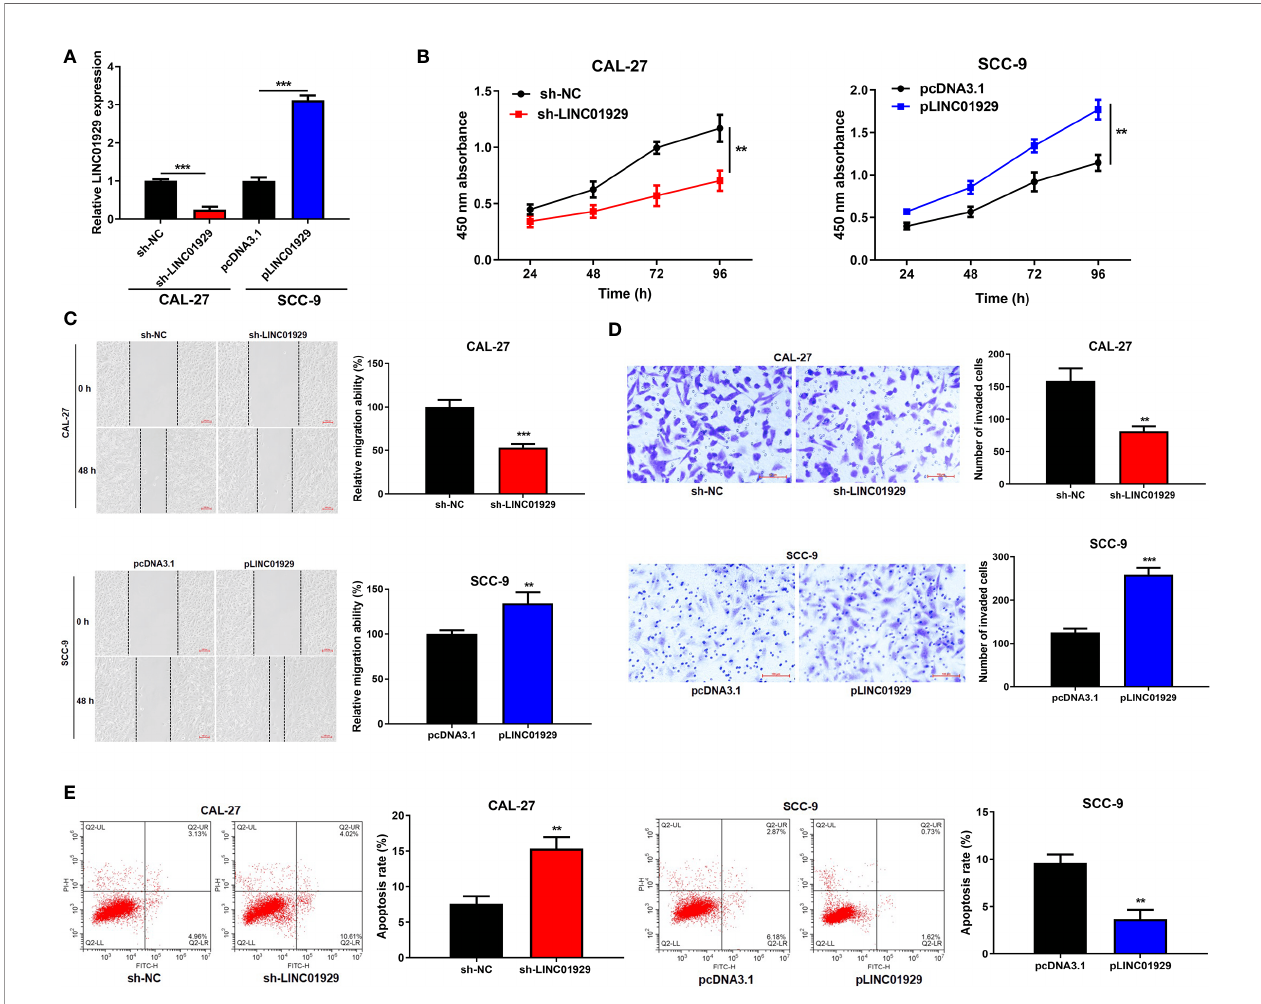
FIGURE 2 | LINC01929 regulated proliferation, migration, invasion, and apoptosis of OSCC in vitro. (A) qRT-PCR analysis was used to examine the ef fi ciency of sh- LINC01929 and pLINC01929. (B) Proliferation was monitored by CCK-8 assay after transfecting sh-LINC01929 or pLINC01929 into selected OSCC cells. (C, D) Wound-healing assay and transwell assay were employed to assess migration and invasion after LINC01929 knockdown or overexpression. (E) The effects of sh-LINC01929 or pLINC01929 on apoptosis was detected by fl ow cytometry. **p < 0.01, ***p <